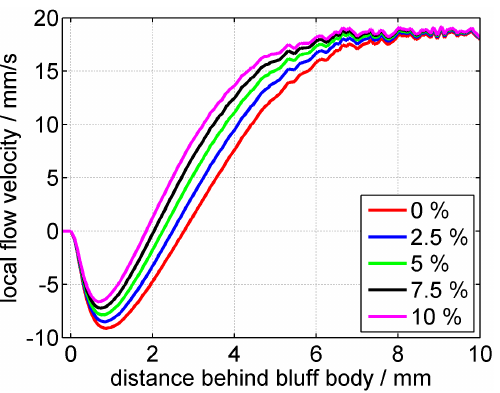
Figure 10. Simulation of the local flow velocity behind the trian- gular bluff body along the symmetry axis for different fractions of methanol in water at a flow rate of 0.08mLs − 1 .